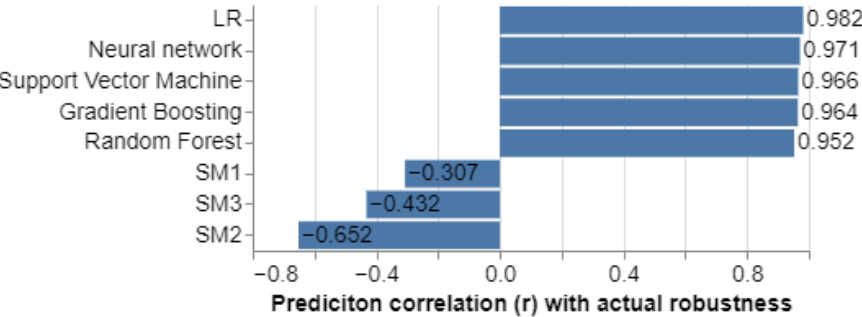
Figure 5. Correlation benchmark of selected RM s and SM s. Key finding: RM s clearly outperform SM s in the approximation of C max